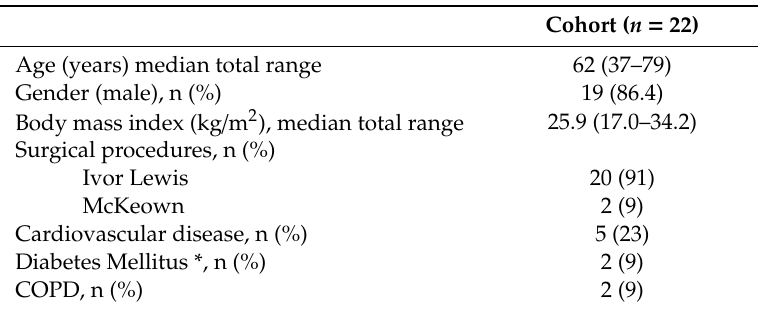
Table 1. Baseline